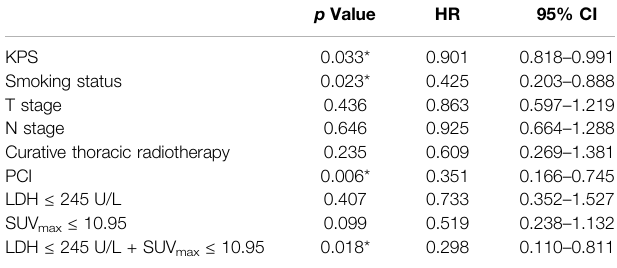
TABLE 4 | Univariate analysis of prognosis in 54 patients with LD SCLC.